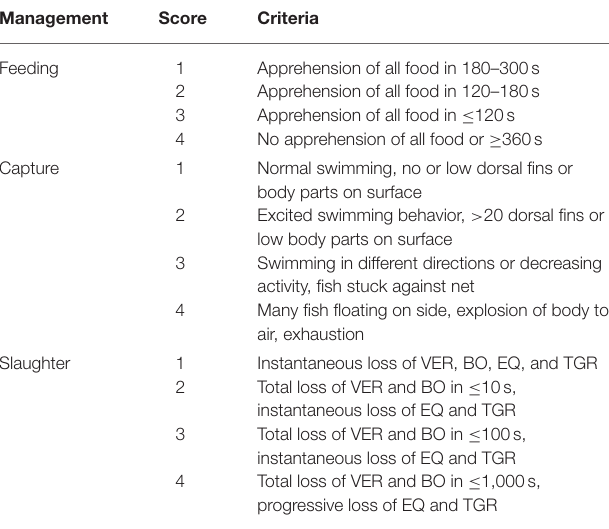
TABLE 5 | Scores used to classify feeding, capture, and slaughter indicators and respected characteristics for on-farm tilapia welfare assessment, based in Noble et al.